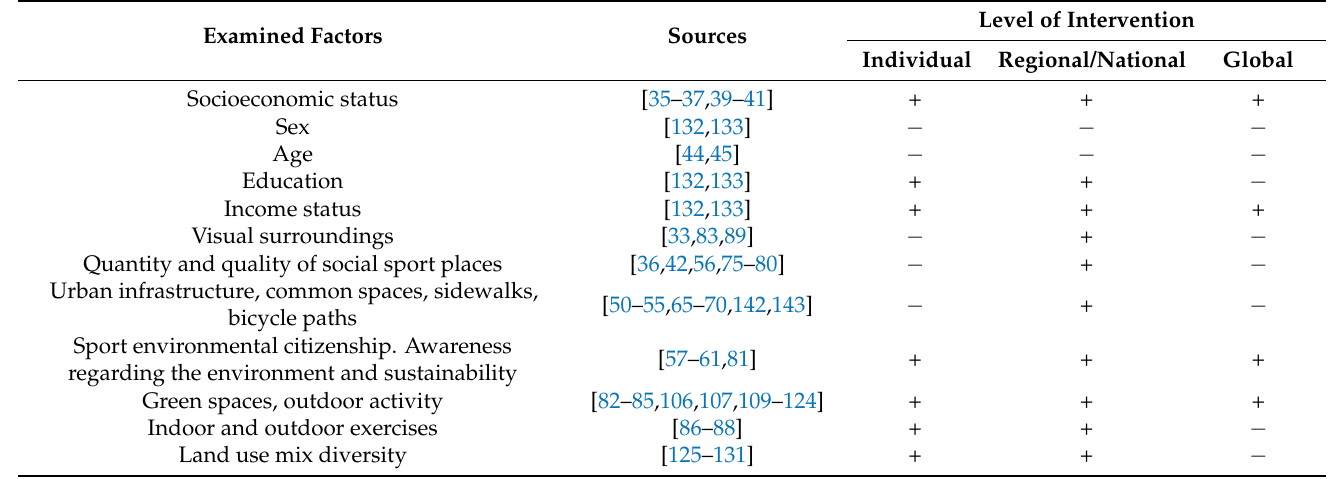
Table 4. Examined factors in terms of environmental-sports-sustainability and the possibility of changing them on individual, regional/national, and global